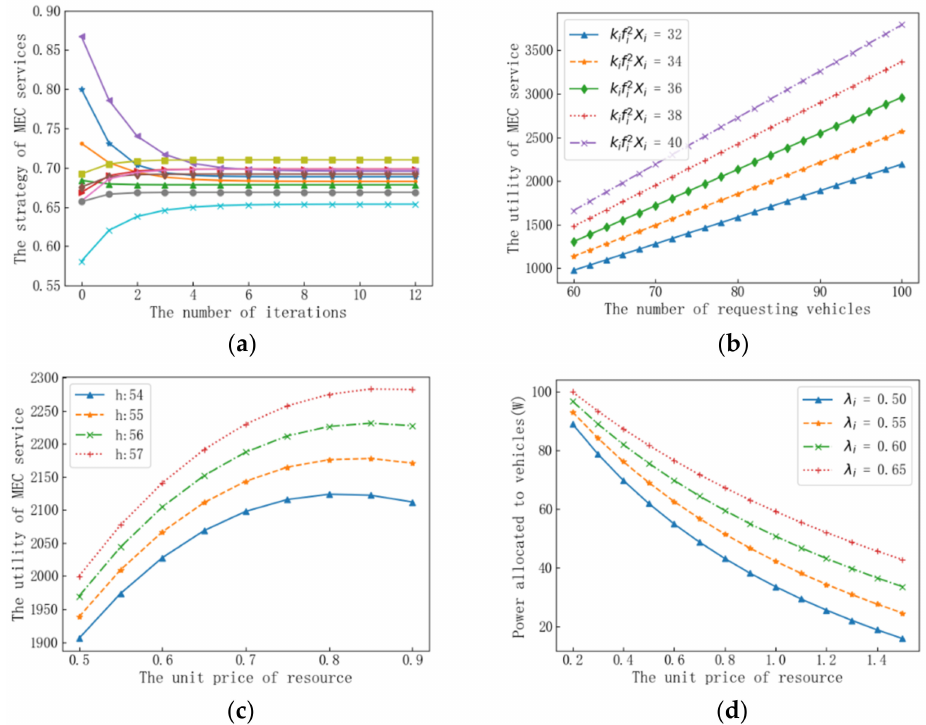
Figure 2. ( a ) is an iterative process of finding the optimal strategy using the gradient descent method for 10 MEC servers, ( b ) is the effect of the number of vehicles and the computational cost of vehicles on the MEC server utility, ( c ) is the impact of resource pricing and channel conditions on MEC server utility and ( d ) is the impact of resource pricing and energy consumption on transmit